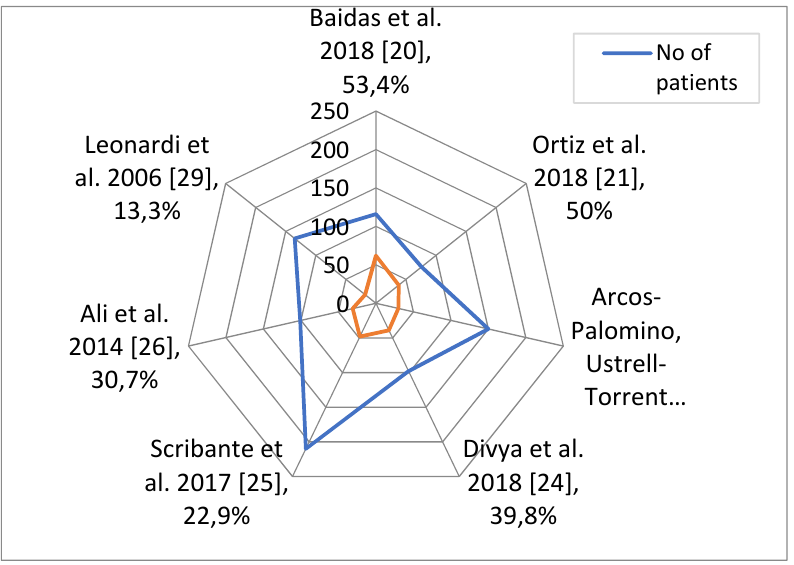
Figure 2. Total number of patients included in each study, and numbers and percentages of patients with PDC.